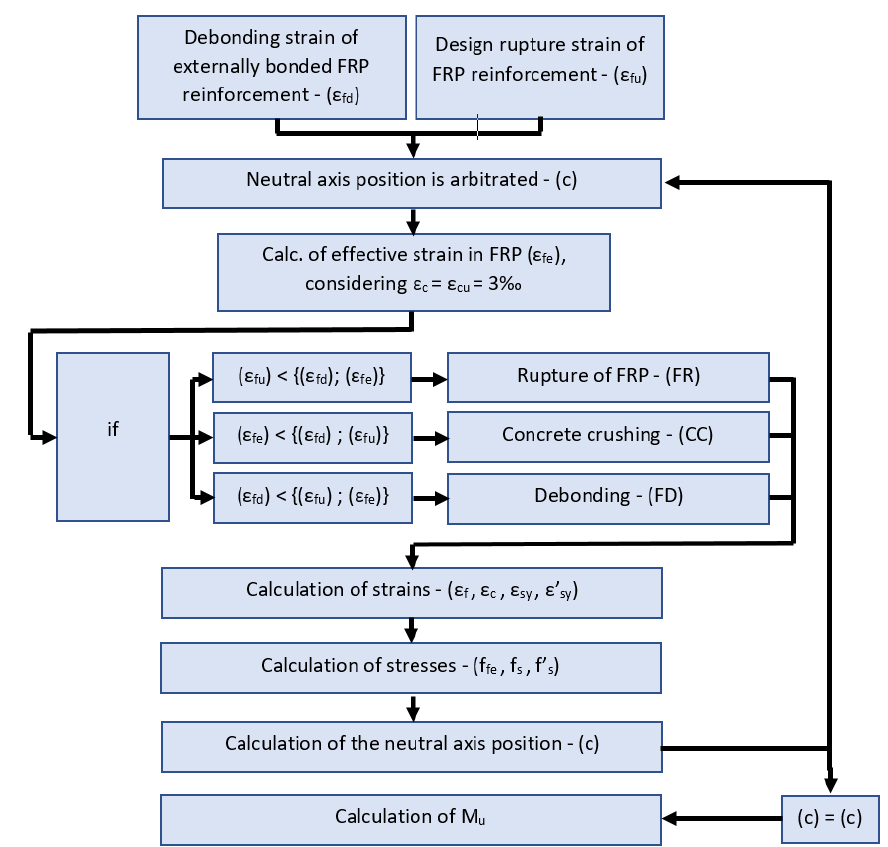
Figure 1. Flowchart of the calculation methodology adopted for the FIB and ACI